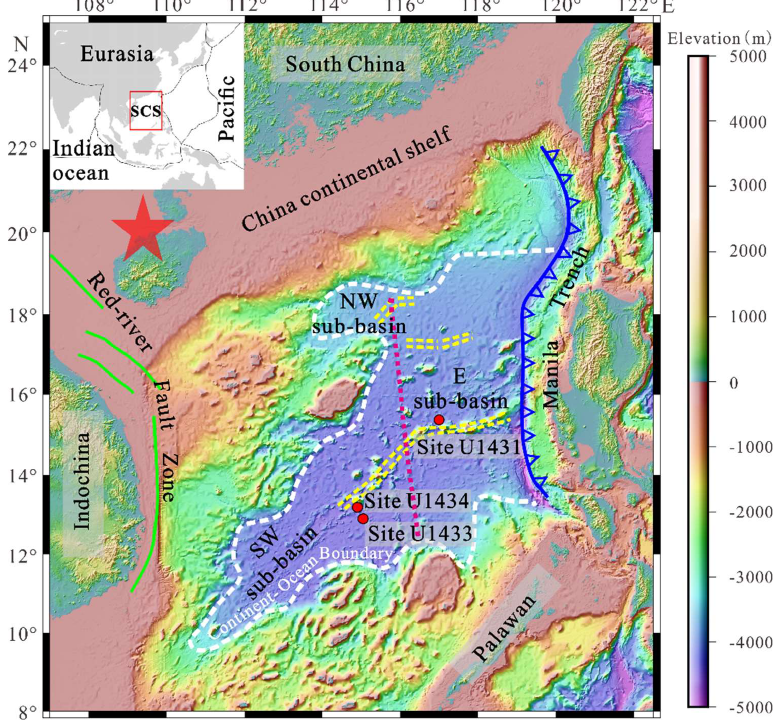
Figure 1. Geologic setting of the South China Sea (SCS) and the locations of Sites U1433 and U1434 of International Ocean Discovery Program (IODP) Expedition 349. Yellow dashed lines indicates the fossil spreading ridge, burgundy dashed line suggests the Zhongnan fault, white dashed line demonstrates continent-ocean boundary, green lines mark the red-river fault zone, blue line represents the Manila subduction zone and its subduction direction, and the red pentagram shows the inferred location of the Hainan plume